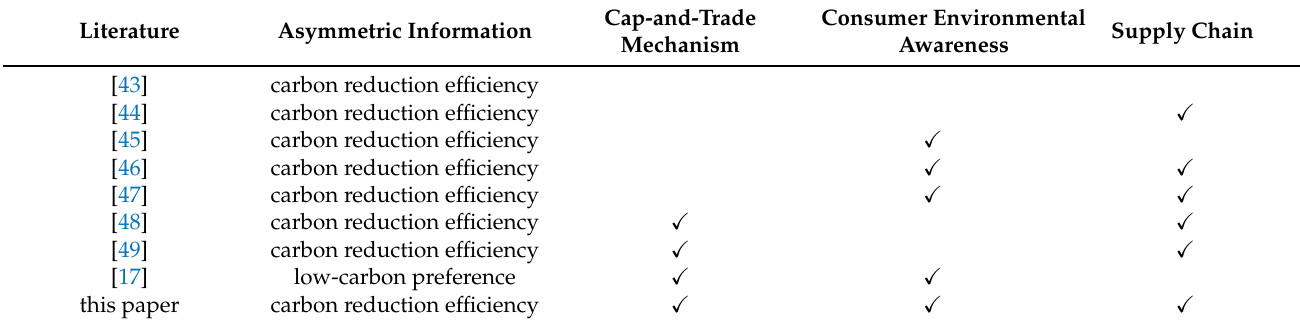
Table 1. Key similarities and diferences in